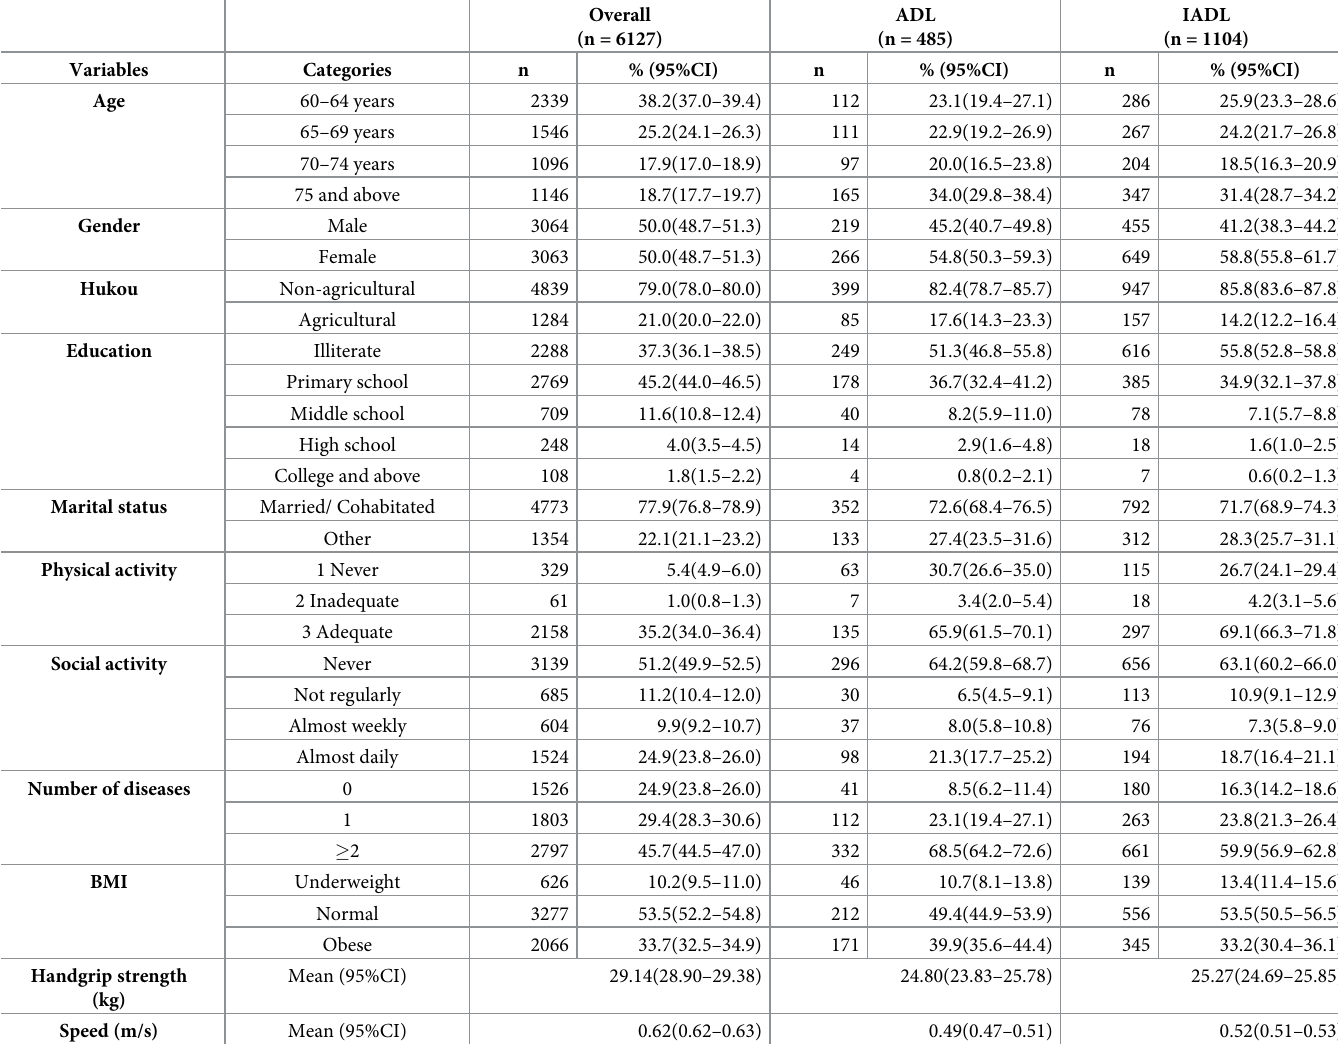
Table 1. Demographic characteristics and health-related information of the